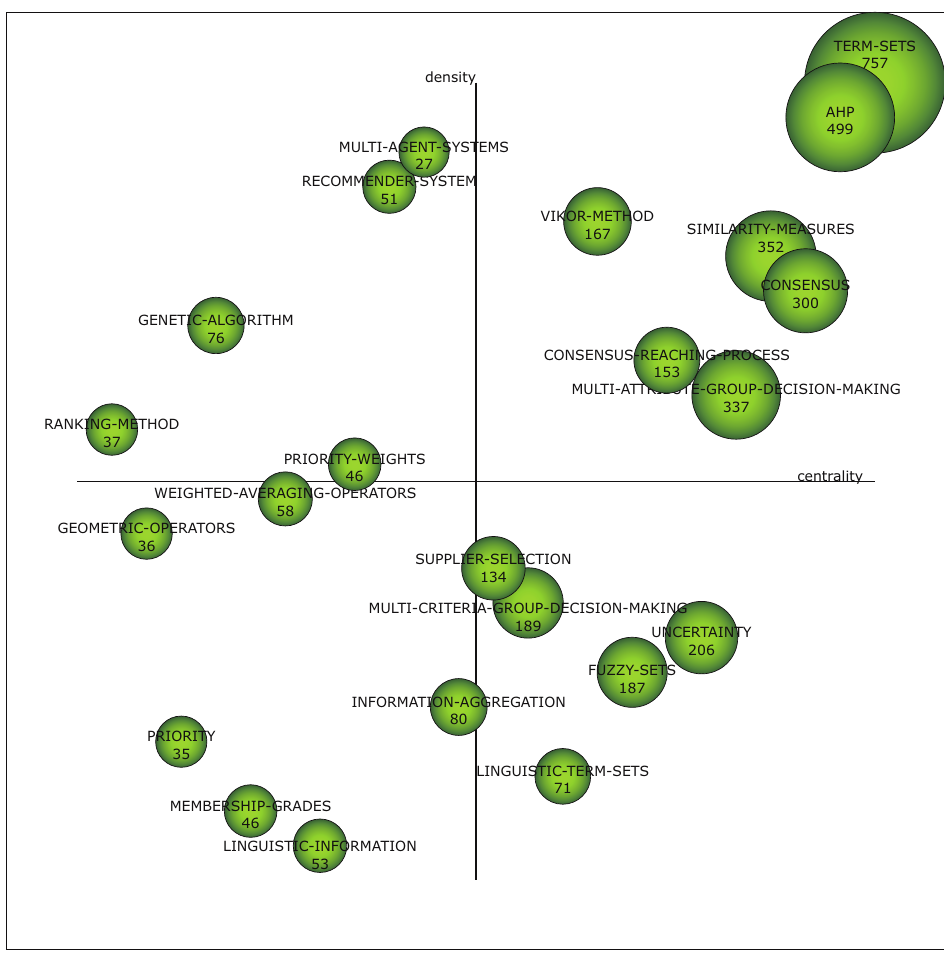
Figure 14. Strategic diagram for the 2015–2019 period. Table 5. Performance of the themes in the 2010–2014